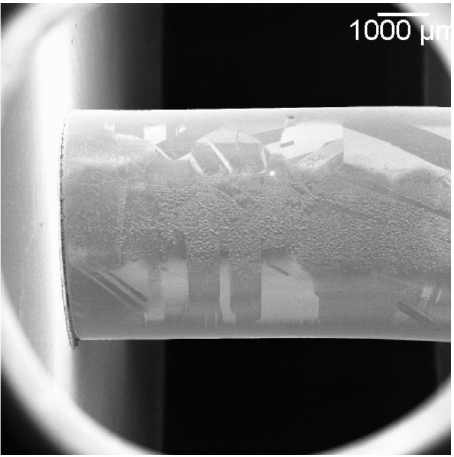
FIG. 18. PBG and pillbox breakdown rate vs maximum surface magnetic field for 170 ns pulse length.